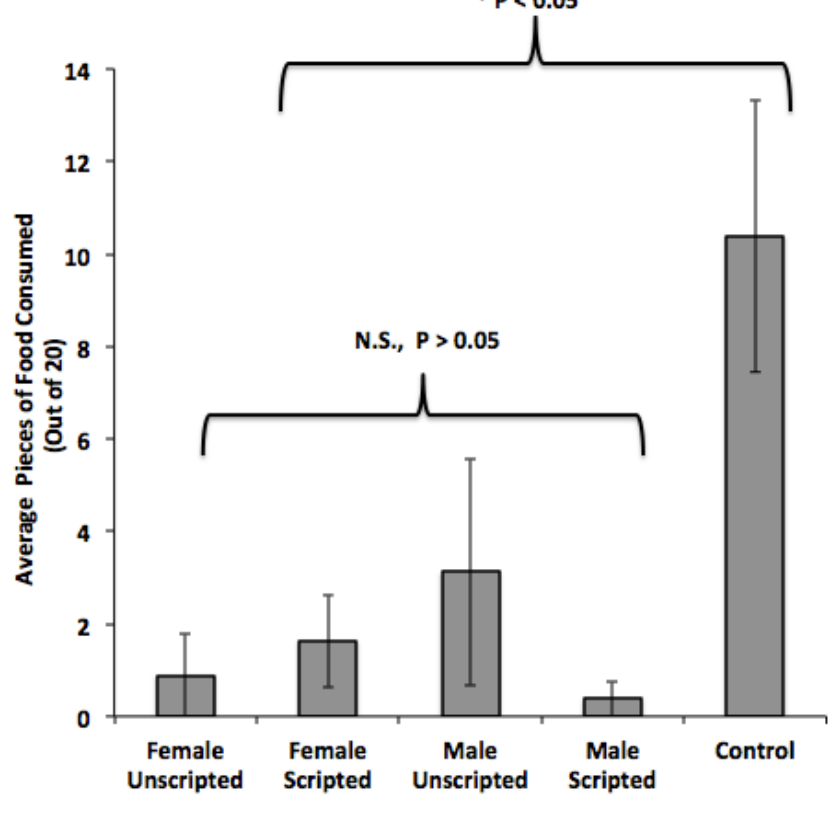
Figure 3. Average amount of dry food consumed across human scolding conditions. Error Bars = ±